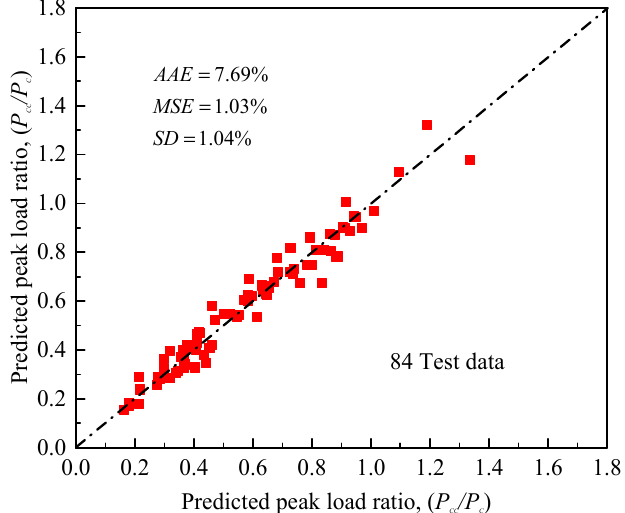
Figure 12. Comparison between experimental and predicted peak load ratios for FRP-confined RC columns.